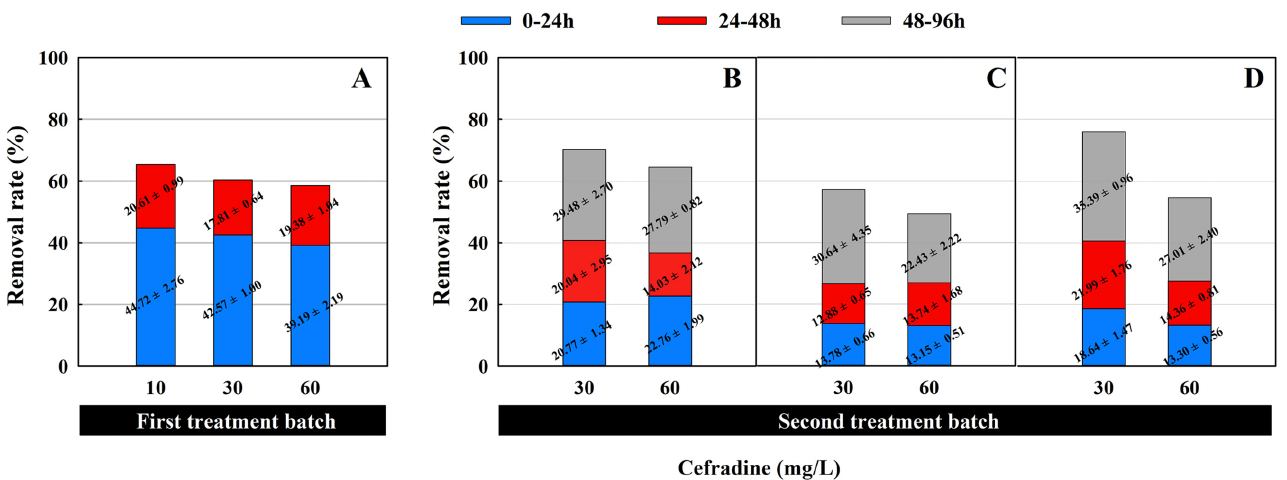
Fig 4. The removal rate of cefradine by C . pyrenoidosa . (A) In the first treatment batch. (B) In the second treatment after a first treatment batch at 10 mg/L. (C) In the second treatment after a first treatment batch at 30 mg/L. (D) In the second treatment after a first treatment batch at 60